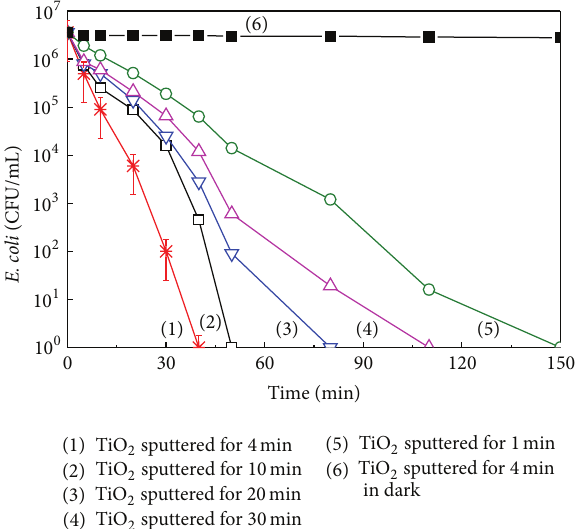
Figure 6: E. coli survival on TiO 2 HIPIMS-sputtered (5A) on polyester for different times in the dark and under solar simulated irradiation (50 mW/cm 2 ).